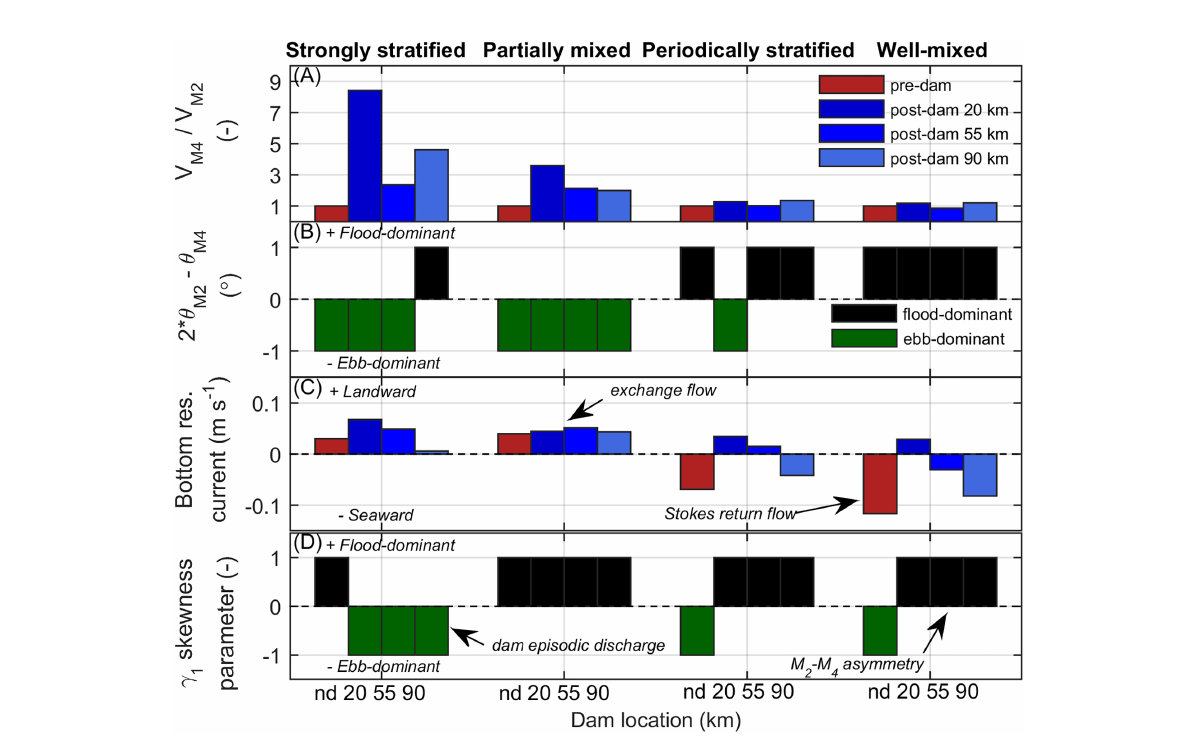
FIGURE 5 Pre- and post-dam tidal asymmetry for different dam locations and estuarine types. (A) Ratio of M 4 to M 2 tidal constituent velocity amplitude ( v M4 / v M2 , -) with values normalized to each type ’ s pre-dam case, (B) M 2 and M 4 tidal constituent velocity relative phase difference (2 q M2 – q M4 , °) binned based on dominance, (C) bottom residual currents (m s -1 ), and (D) bottom velocity skewness parameter ( g 1 , -) with values binned based on dominance. The no dam case is denoted nd. All results correspond to scenarios with discharge intervals D t = 3